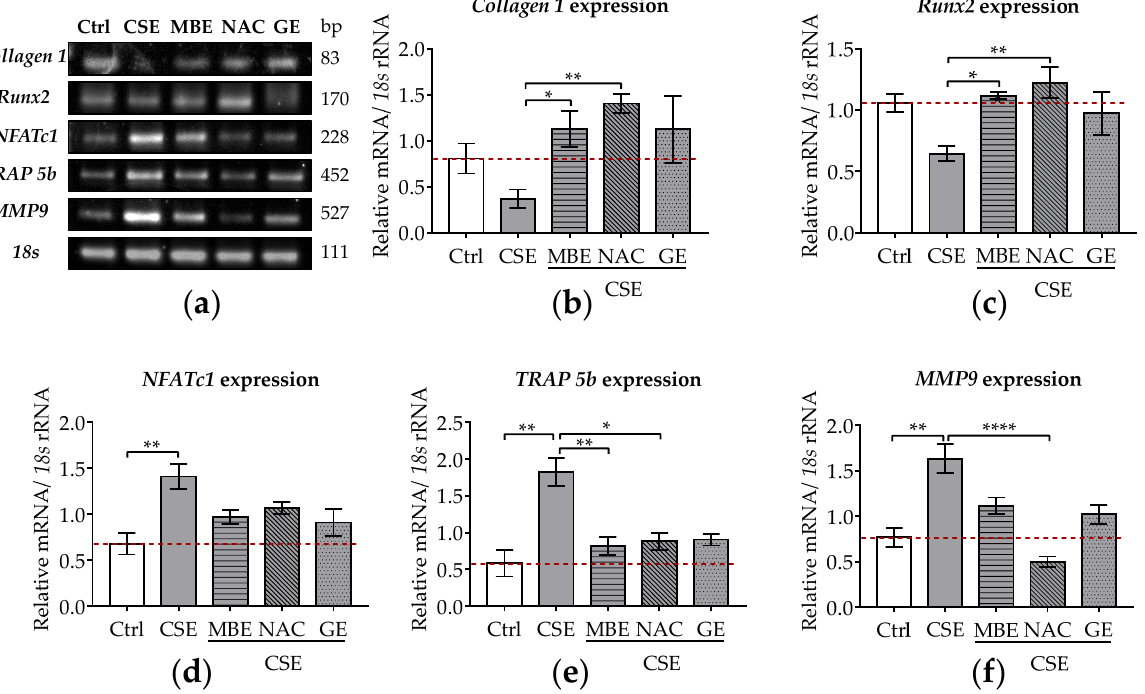
Figure 2. The expression levels of osteoblastic and osteoclastic genes in the co-culture system under exposure to CSE and antioxidants. SCP-1/THP-1 co-culture system was exposed to 5% CSE with or without antioxidants for 7 days. The gene expression levels were evaluated by RT-PCR. 18s rRNA served as a housekeeper gene. ( a ) Representative RT-PCR image showed the gene expression of Collagen 1, Runx2, NFATc1, TRAP 5b , and MMP9 in 3D co-culture system with different treatments. Expression levels of Collagen 1 ( b ), Runx2 ( c ), NFATc1 ( d ), TRAP 5b ( e ), and MMP9 ( f ) mRNA were measured on day 7. Statistical differences were determined using the Kruskal–Wallis test followed by Dunn’s multiple comparison test. Data are presented as means ± SEM, and the significance is shown as * p < 0.05, ** p < 0.01, and **** p < 0.0001 vs. CSE group. N = 3, n = 2.